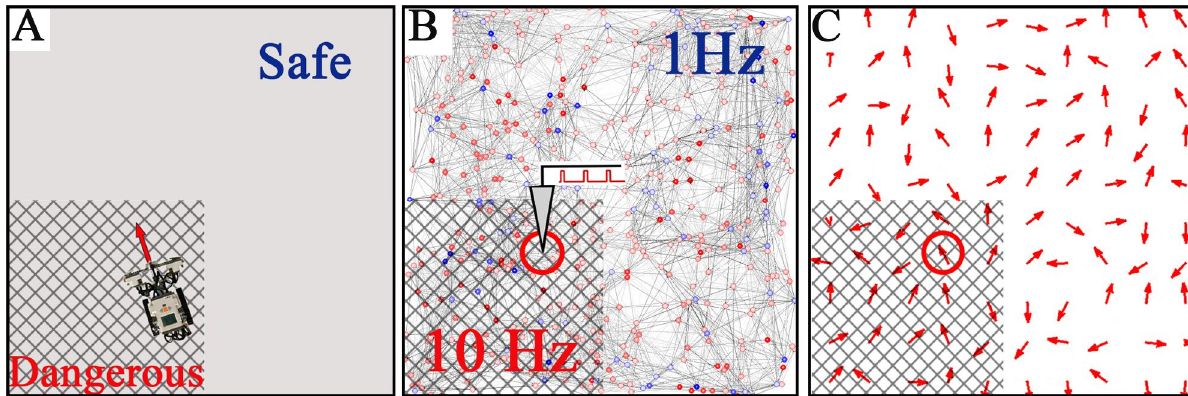
Figure 6. Embodiment of the SNN in a moving robot. ( A ) The robot is controlled by the SNN and moves in a square arena divided into safe and dangerous (marked with a grid) zones. ( B ) The robot location determines the stimulation area in the network space (red circle). The stimulation frequency is 1 and 10 Hz for the safe and dangerous zones, respectively. ( C ) The vector field of functional connections (red arrows) in the SNN determines the robot’s direction and speed (red circle delimits the area controlling the robot movement).